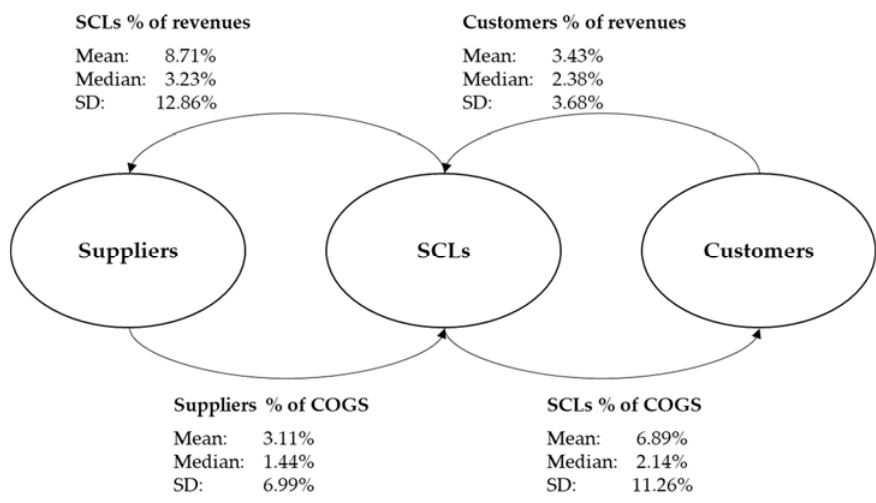
Figure 3. Relationship strength within the SCL networks. Table 3. Distribution of central sample firms in SIC